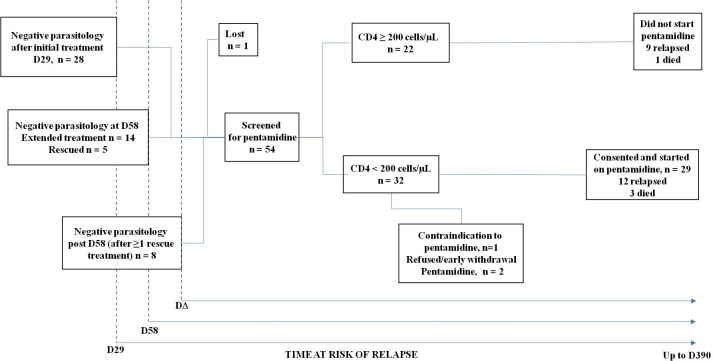
Follow-up period flow diagram.The maximum follow-up time was one year from initiation of VL treatment. However, patients only entered the cohort study on achieving negative parasitology. Hence, in general, patients had less than one year of follow-up in the cohort study.